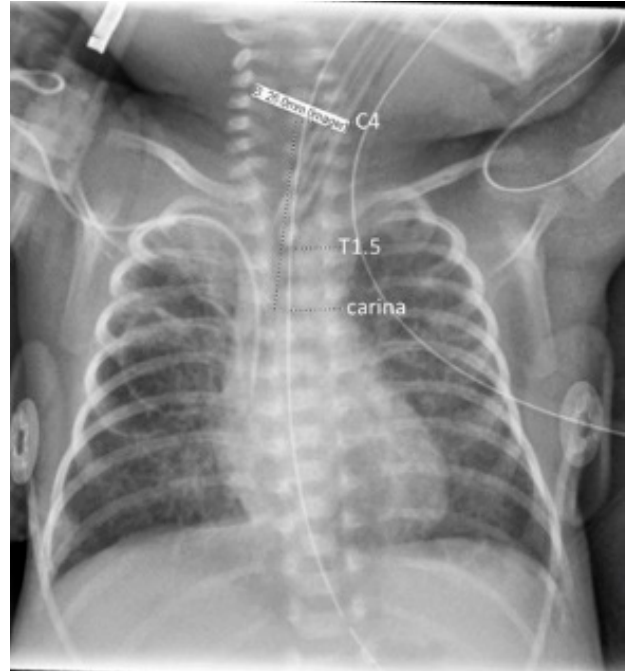
Figure 1. Chest radiograph illustrating annotations of anatomical landmarks with the dashed line markers, underlying the measurements; tracheal length was taken as the carina–C4 distance.